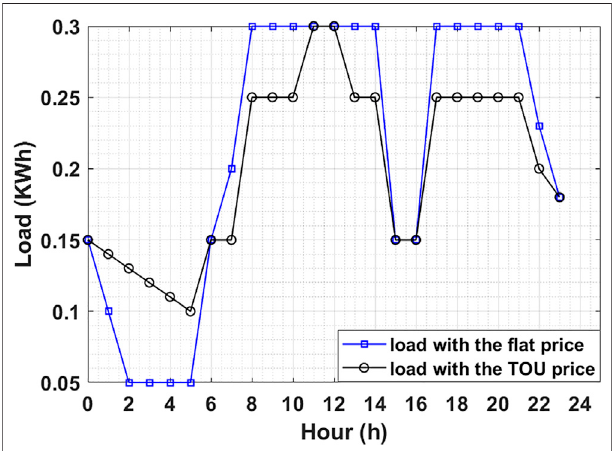
FIGURE 8 | Load of the elevator between the fl at price and TOU price.